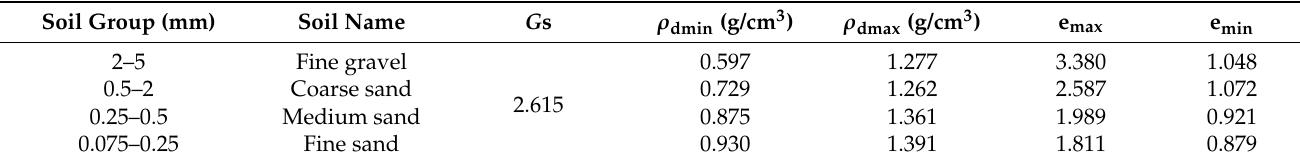
Figure 4. Diagram of four particle size of volcanic soil. Table 2. Physical parameters of volcanic soil.